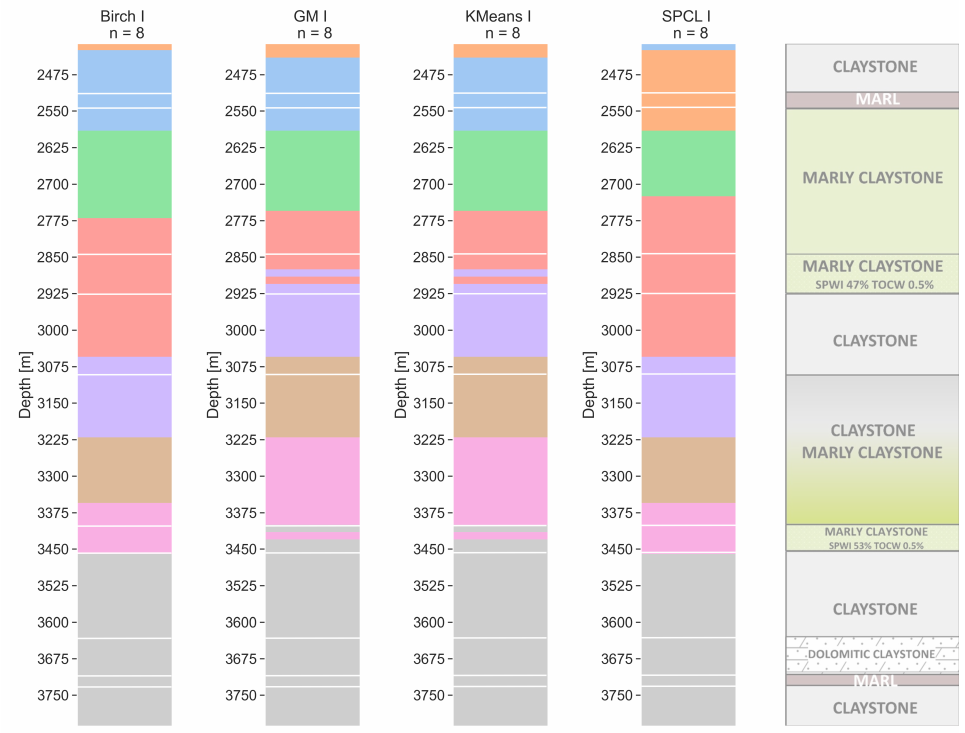
Figure 8. Walkaway VSP resolution clustering models for a number of clusters equal to 8 with lithology from well core (with lines). Clustering methods: BIRCH—balanced iterative reducing and clustering using hierarchies, GM—Gaussian mixture model, k-means, and SPCL—spectral